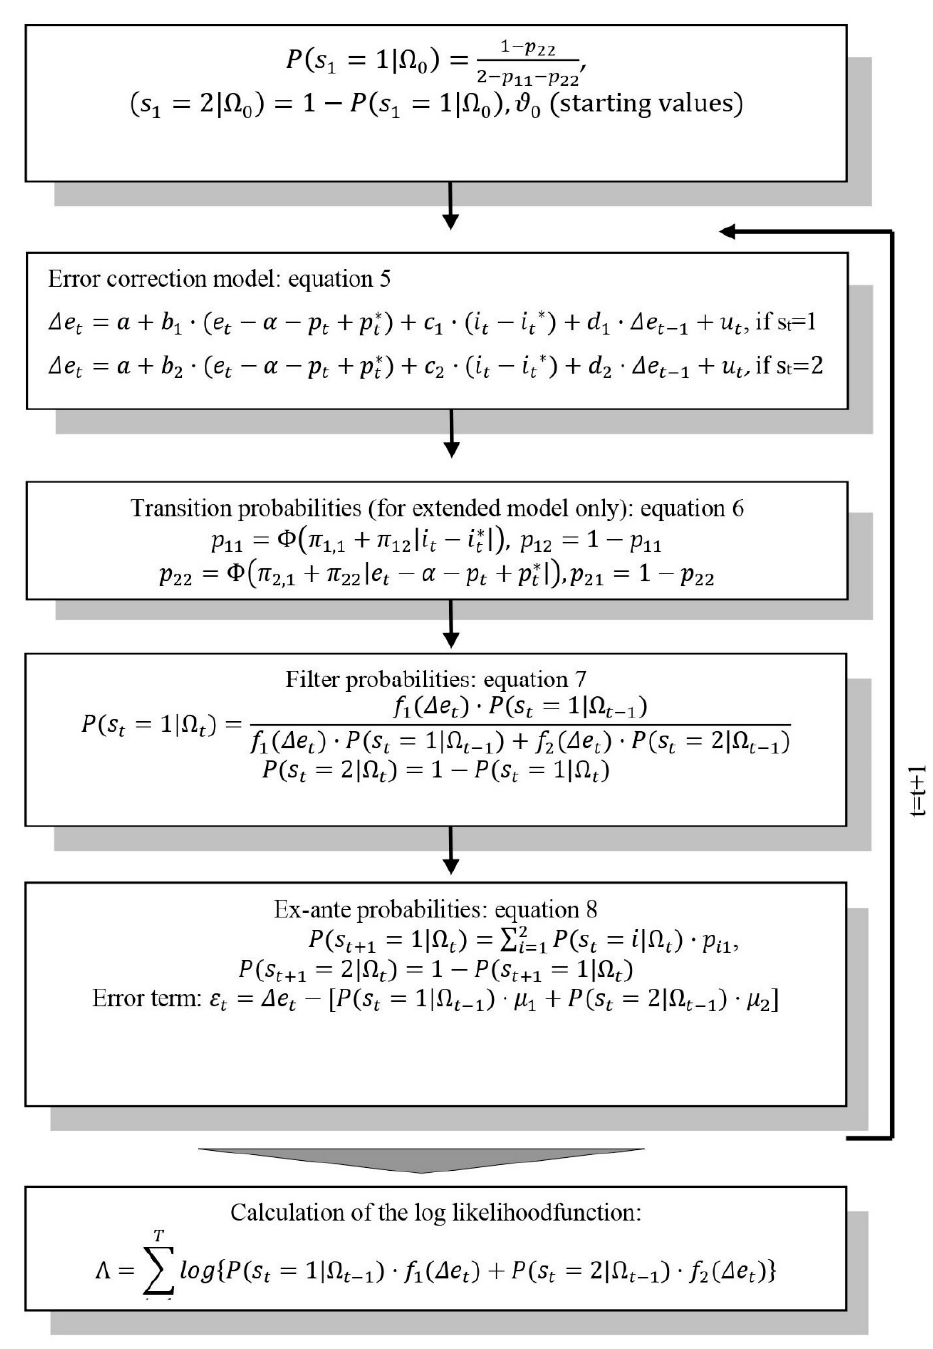
Figure 1. Flowchart for the calculation of the likelihood